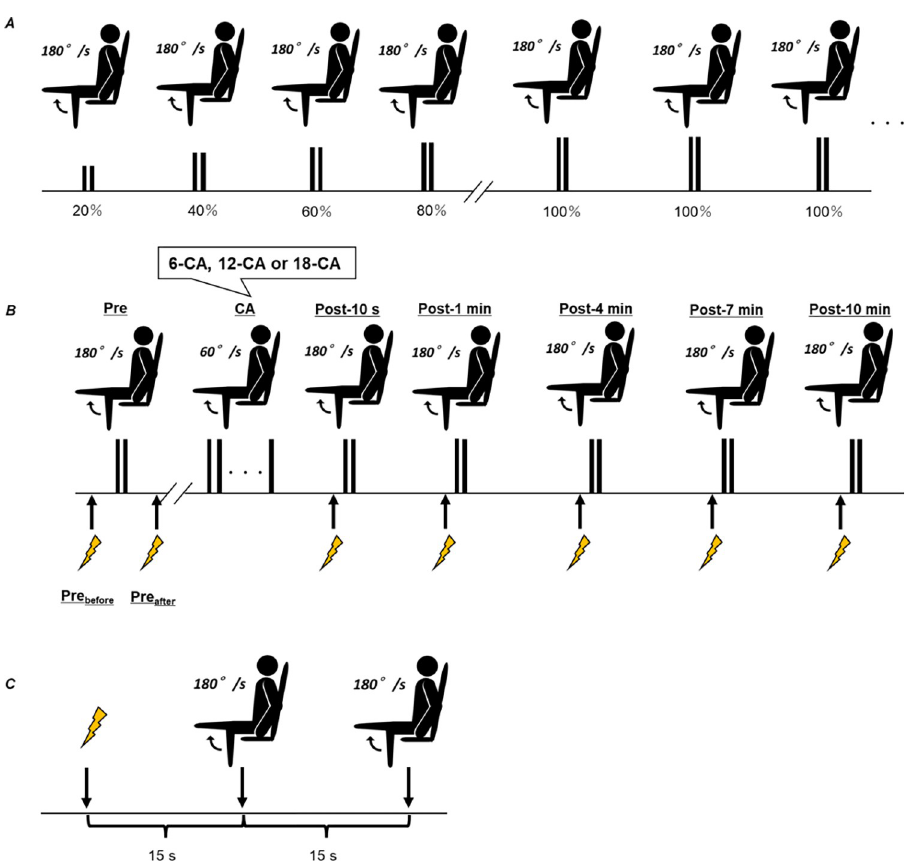
Fig 1. Experimental overview. ( A ) Task-specific warm-up procedure ( B ) Experimental procedure for the 6-CA, 12-CA, and 18-CA protocols. ( C ) The details of the test protocol after each CA. CA, conditioning activity.